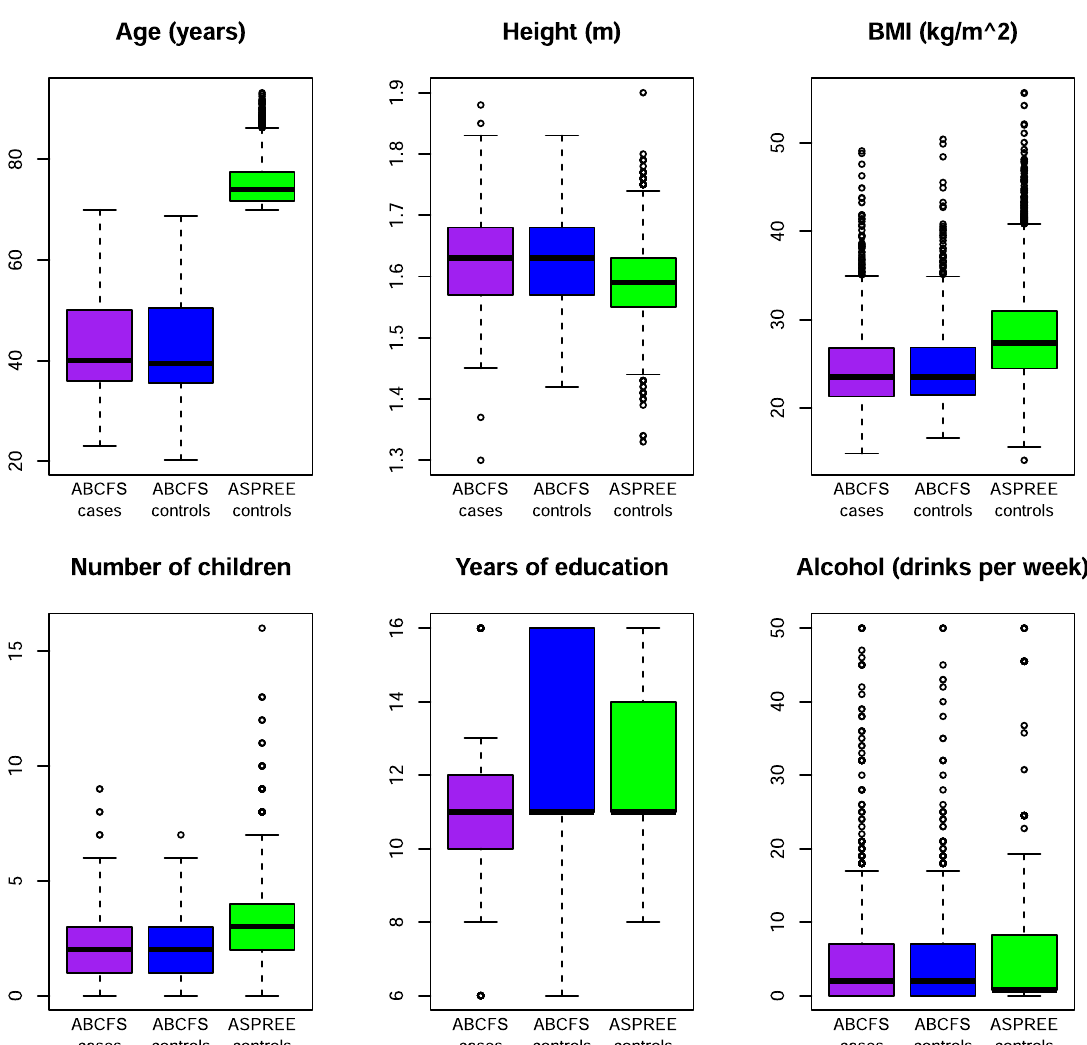
Fig. 1 Box-and-whisker plots of potential confounders. Boxplots of potential confounders, used as adjustment variables in the analyses, for controls from the ASPirin in Reducing Events in the Elderly (ASPREE; in green) study, and for cases and controls from the Australian Breast Cancer Family Study (ABCFS; in purple and blue). Panels are for age (years), height (m), body mass index (kg/m 2 ), number of children, education (years) and alcohol consumption (drinks per week), as indicated. For each boxplot, the horizontal lines are at the potential confounder ’ s median (bold line), 25th and 75th percentiles (horizontal bounds of the box) and most extreme data points within a distance, from the box, of 1.5 times the interquartile range (shorter horizontal